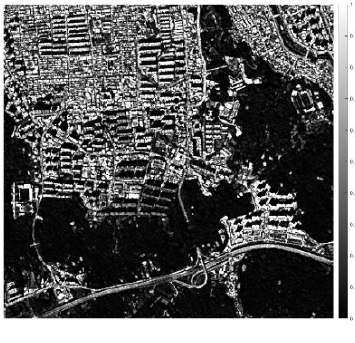
( c ) Figure 6. Multiresolution segmentation images: ( a ) Site 1; ( b ) Site 2; and ( c ) Site 3 imagery. Table 3. Multiresolution segmentation parameter values by site.